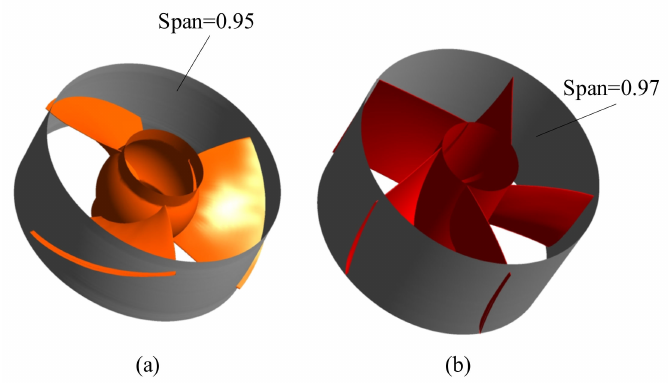
Figure 10. Cylindrical section of ( a ) impeller and ( b ) rear guide vane.